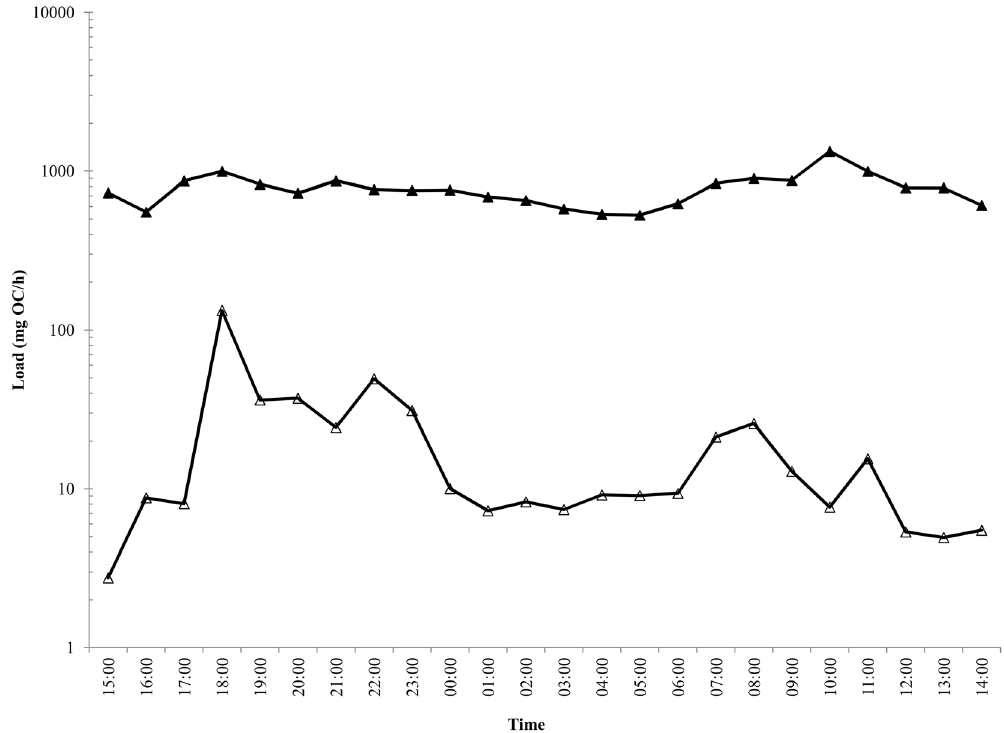
Figure 3. Oseltamivir Carboxylate Load in Waste Water. Calculated hourly influent load of OC (mg/h) for Oxford WWTP (closed) and Benson WWTP (open).